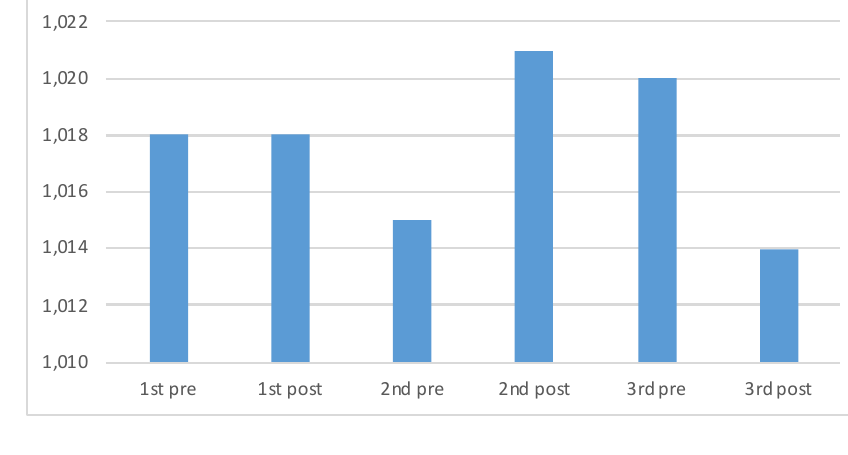
Figure 3. Changes in USG values of female university students before and after beach handball